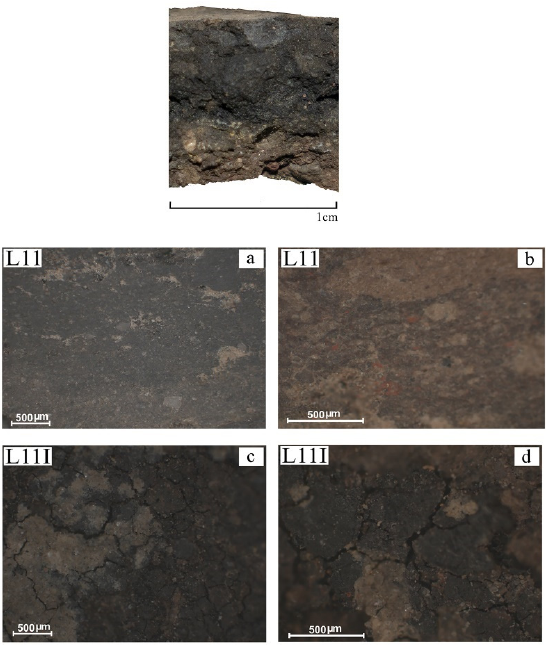
Figure 5. OM for the Costi ș a ceramic fragments (L1–L10) from Piatra Neam ț – Lut ă rie (C) ceramo- clasts; (RC) reused ceramoclasts). Appl. Sci. 2021 , 11 , x FOR PEER REVIEW The presence of ceramoclasts was also detected macroscopically, but microscopically reused ceramoclasts were identified. The reused ceramoclasts result from crushing other pottery fragments, which, in their turn, also contain ceramoclasts added in the paste of the new vessels. They are present only in the case of cooking (L2, L3, L8), storage (L5, L6, L7) and serving vessels (L10).